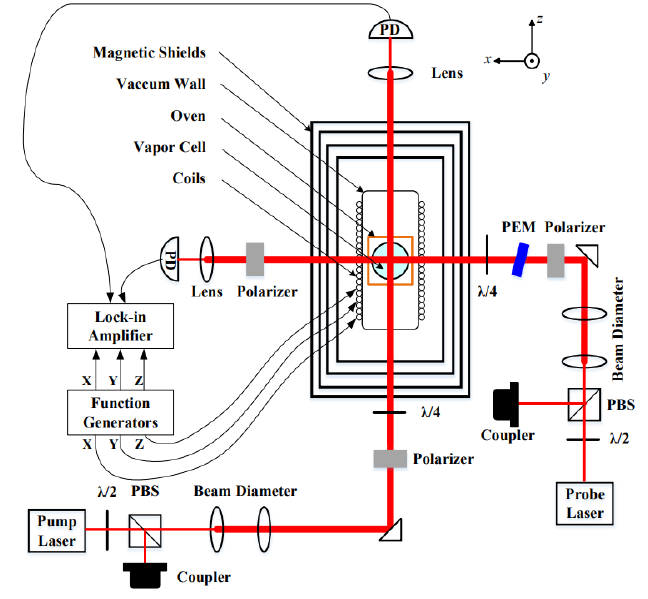
Figure 2. Experimental setup. λ/4: quarter - wave plate. λ/2: half -wave plate. PD: photodetector. PBS: polarized beam splitter. PEM: photoelastic modulator.